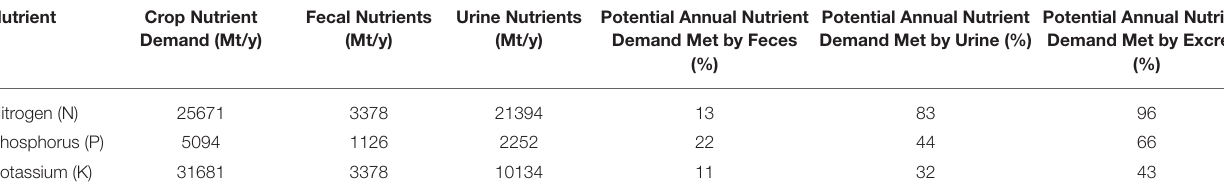
TABLE 3 | Estimated potential contribution of excreta-derived nutrients to meet crop N, P, and K demand in Haiti. Nutrient